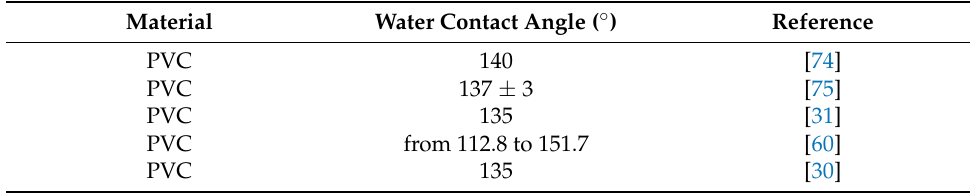
Table 4. Water contact angle ( ◦ ) of PVC nanofiber